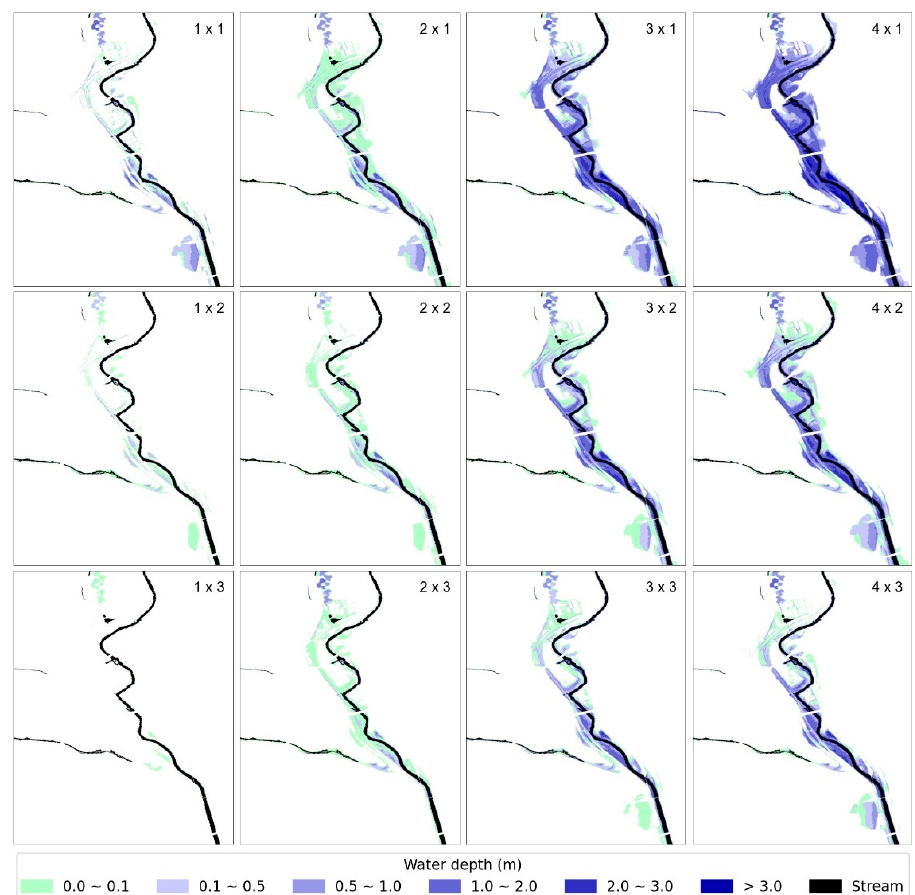
Figure 6. Topological maps of one of the SOMs trained.